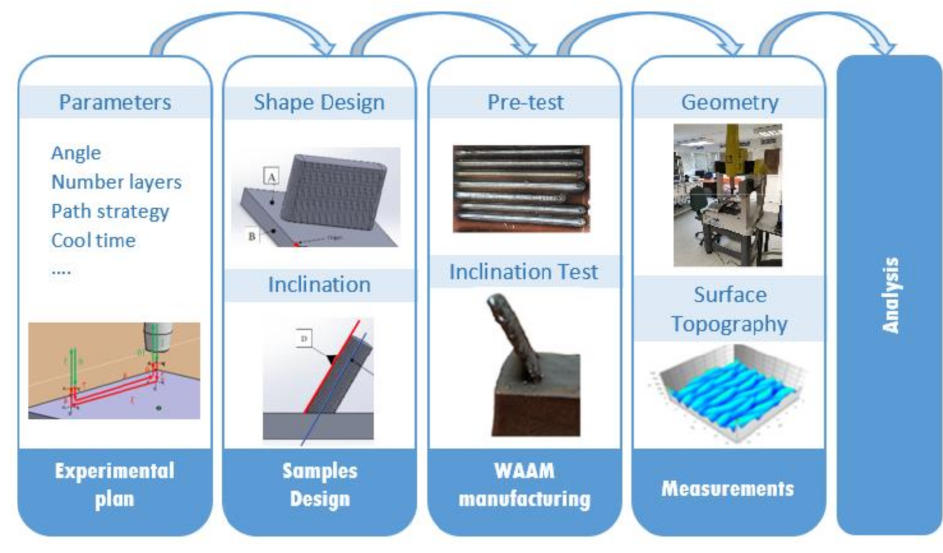
Figure 1. Research